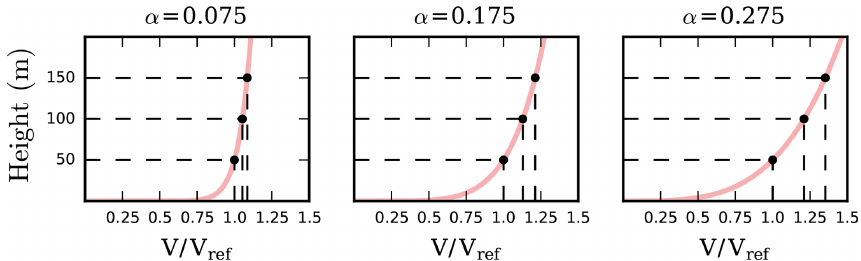
Figure 7. The wind speed profiles for various wind shear exponents. With lower shear exponents the wind speed does not vary dramatically with height. For higher wind shear, there is a significant wind speed increase with height.